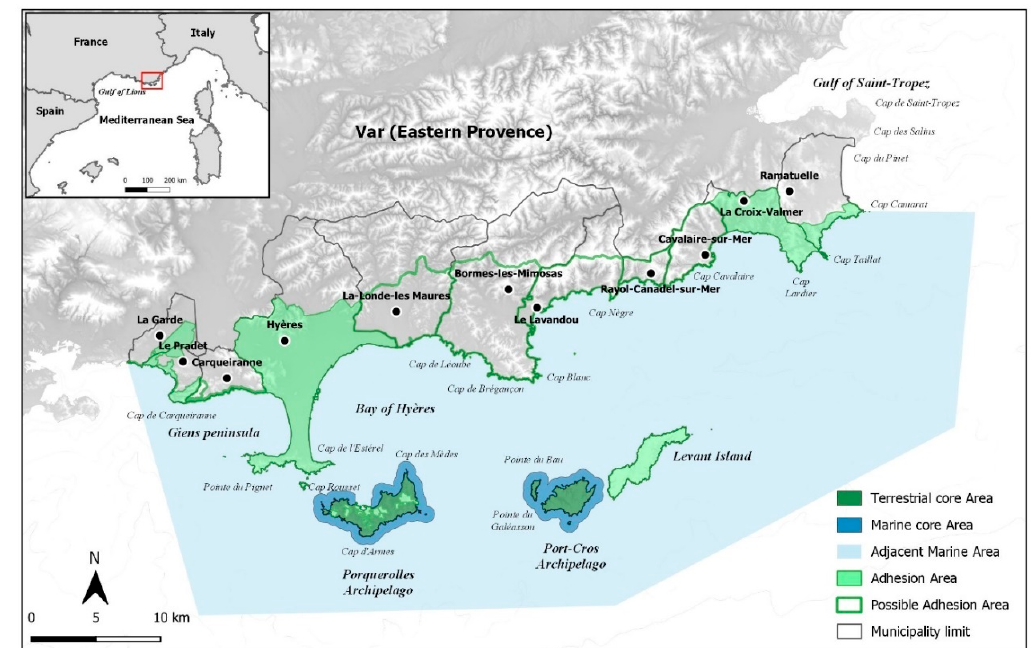
Figure 1. Map of the new Port-Cros National Park (N-PCNP) established in 2016. The initial PCNP, established in 1963, was restricted to the archipelago of Port-Cros. In the municipalities ( communes ) which joined—or not—the N-PCNP, part of the municipality’s area is located outside of the Possible Adhesion Area.